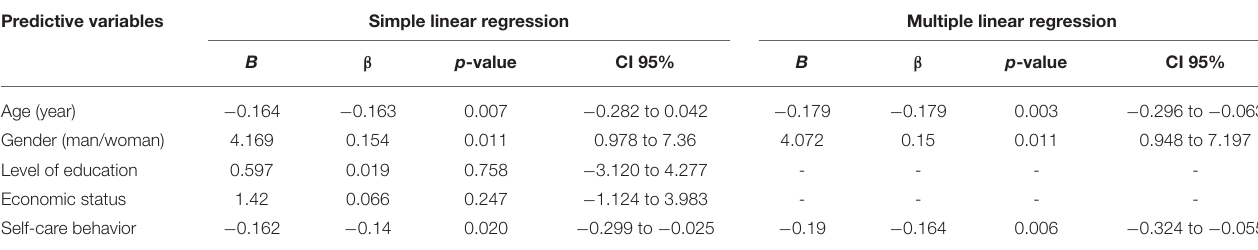
TABLE 2 | Results of body image predictor variables ( n = 280). Predictive variables Simple linear regression Multiple linear